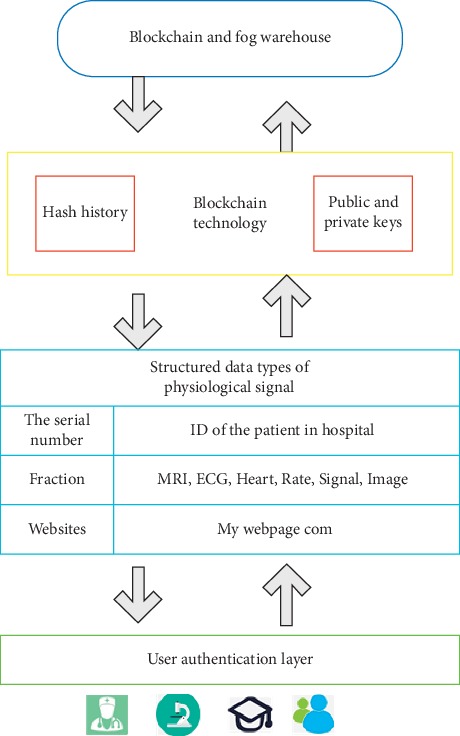
Blockchain based on fog warehouse.